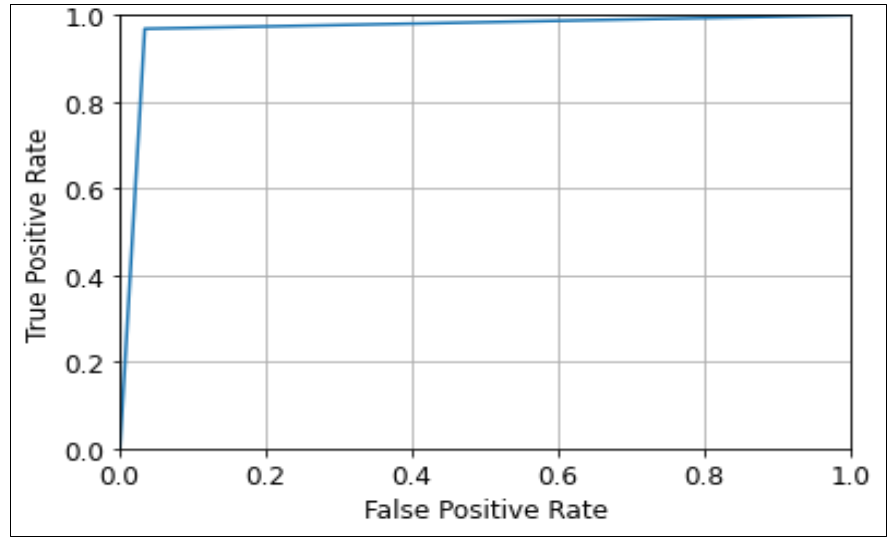
Figure 15. ROC Curve of ResNet50 model.